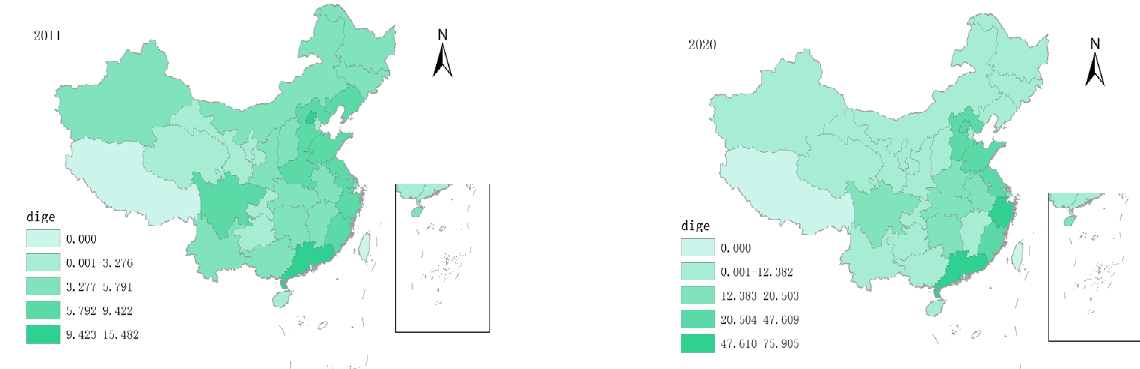
Figure 3. Digital economy development level by provinces in 2011 and 2020.